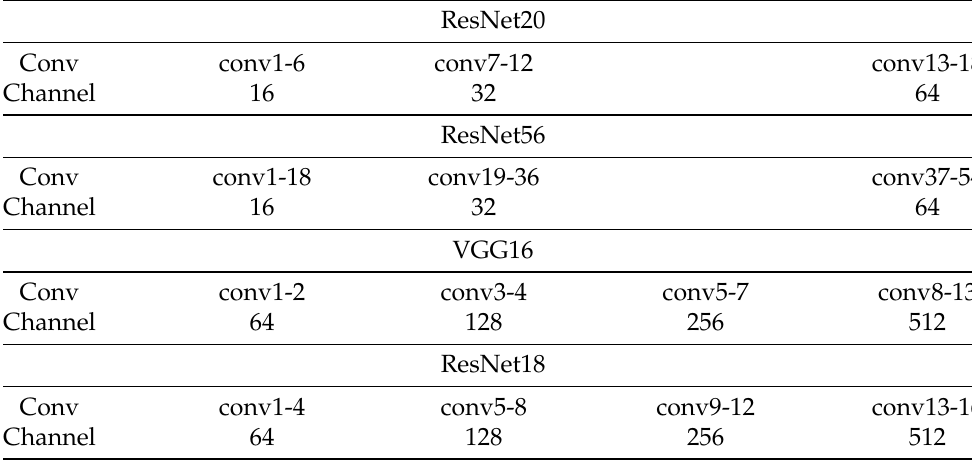
Table 1. The number of channels in ResNet20, ResNet56, VGG16 and